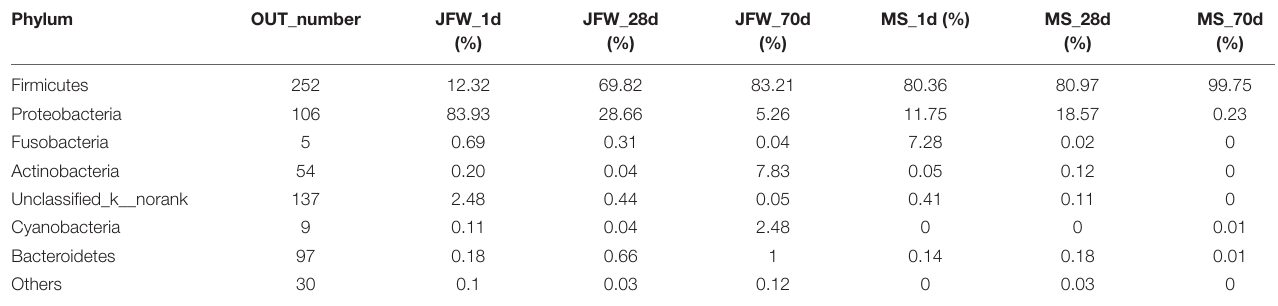
TABLE 2 | The ratio of identified phyla at different developmental stages of Jinfen White and Mashen piglets. Phylum